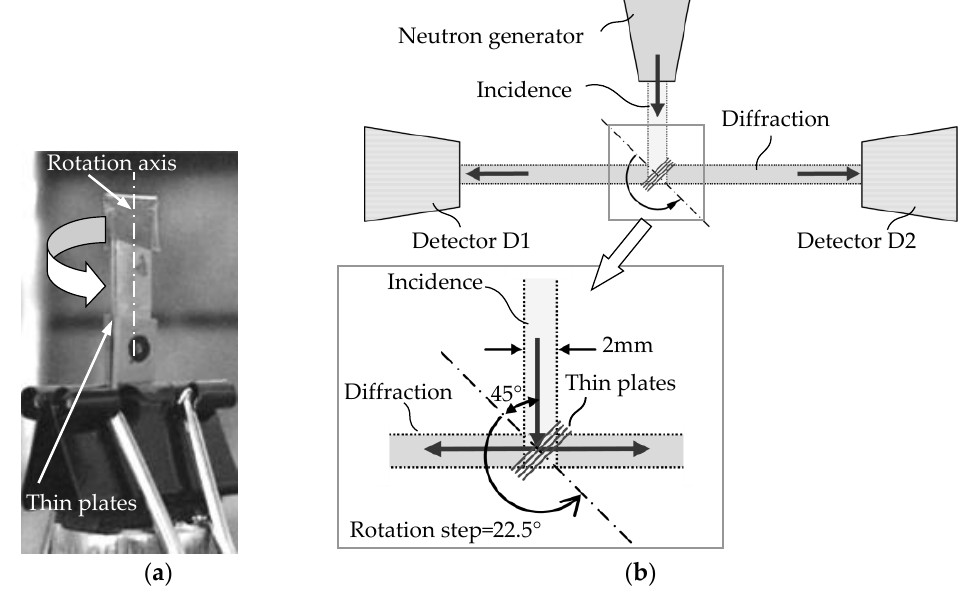
Figure 3. Optical system of neutron diffraction for strain-free lattice constant measurement. ( a ) Side view, ( b ) Top view [13].